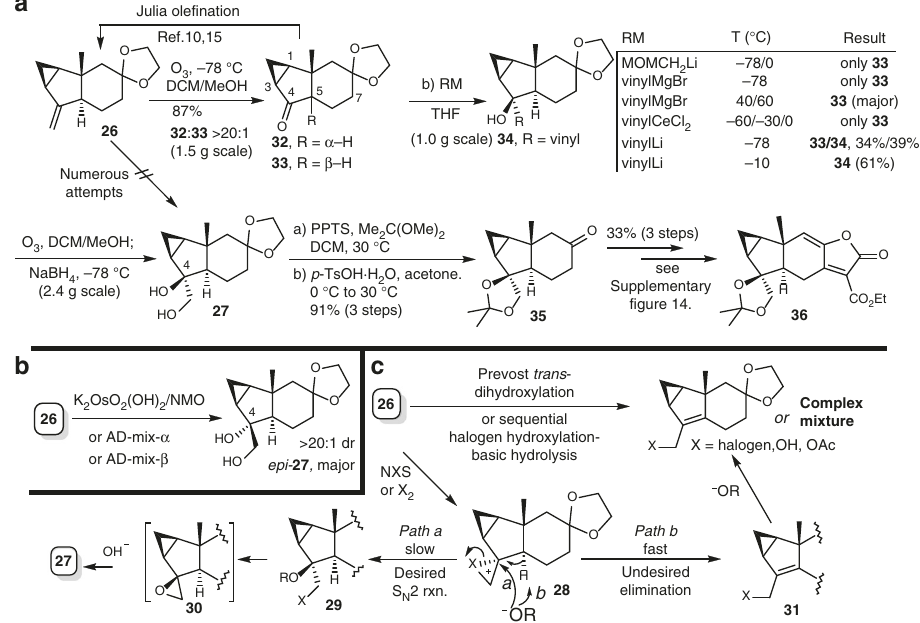
Fig. 4 Synthesis of the dienophile 36 for type 3 [4 + 2] natural dimers. a Compound 36 can be synthesized from 26 in 8 steps. b Direct dihydroxylation of 26 fails to afford the desired diol 27 . c Both Prévost trans -dihydroxylation and sequential halogen hydroxylation-basic hydrolysis fail to afford 27 . PPTS = pyridinium p -toluenesulfonate